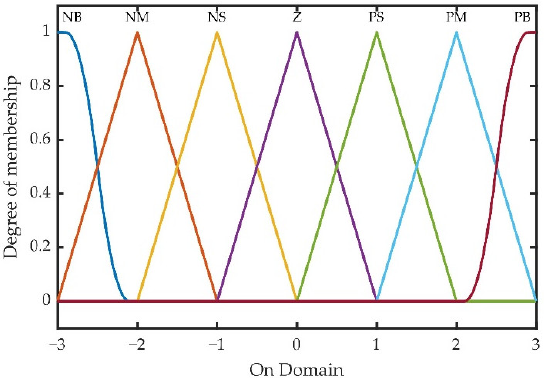
Figure 1. Membership functions of EDS fuzzy controller input and output.